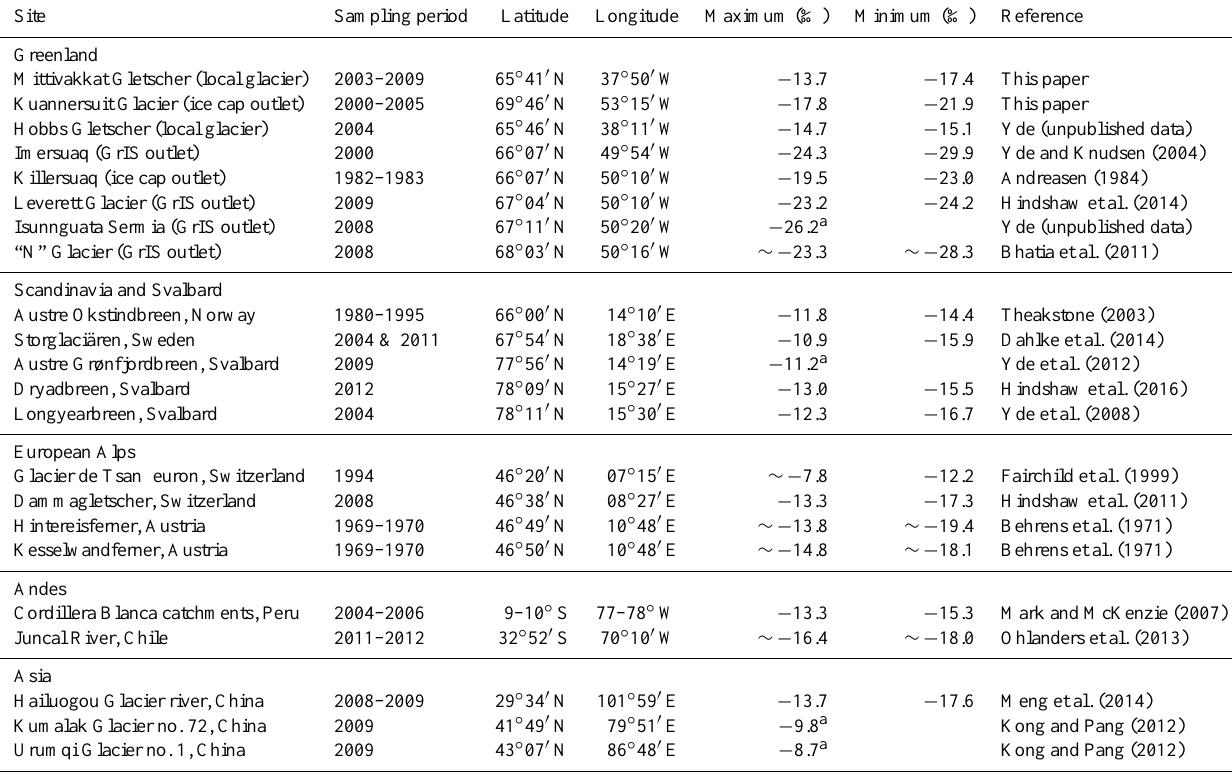
Table 3. Maximum and minimum δ 18 O in glacier